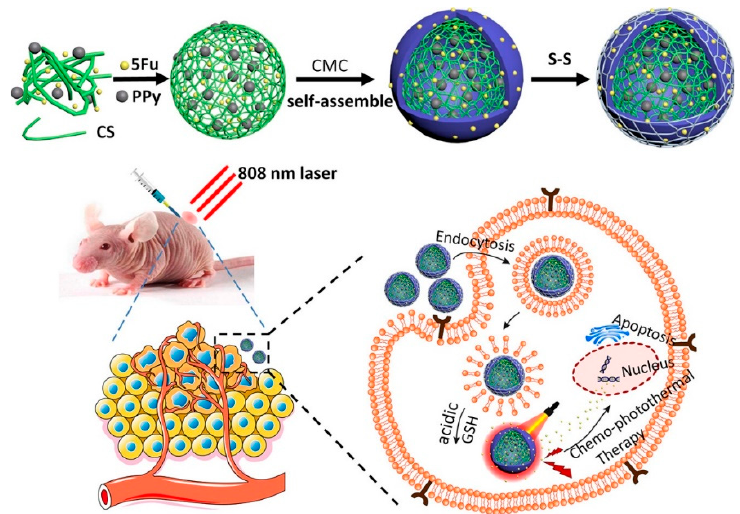
Figure 8. Schematic diagram of the synthesis of a drug ‐ loaded complex of chitosan NPs and carboxymethyl cellulose, and its application in photothermal chemotherapy for tumor cells. Reproduced with permission from [114], 2022, Elsevier.